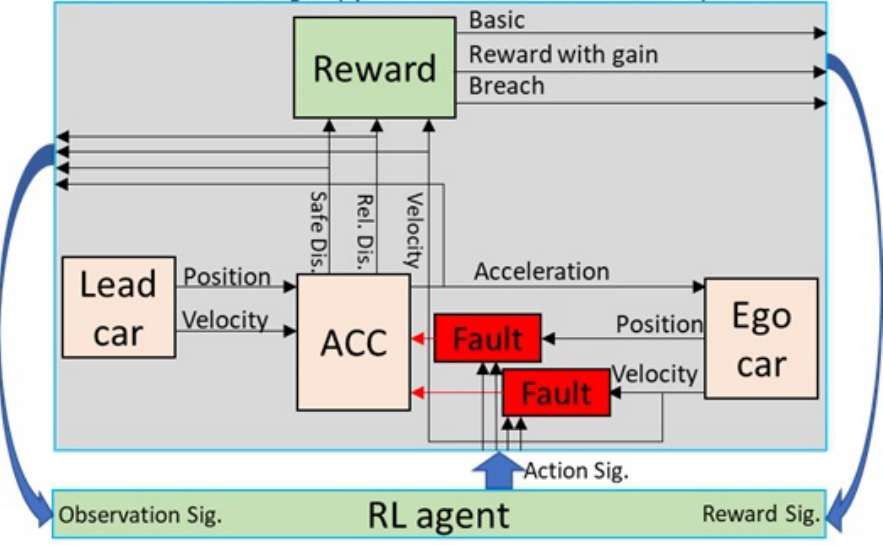
Figure 7. Fault injection setup for ACC using